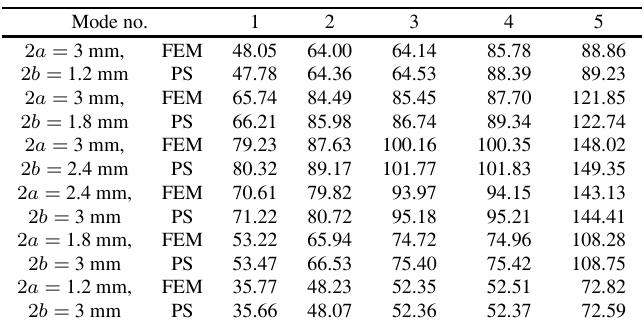
Table 10 The effect of the aspect ratio ( a/b ) on frequencies ( R 1 = 25 mm, R 2